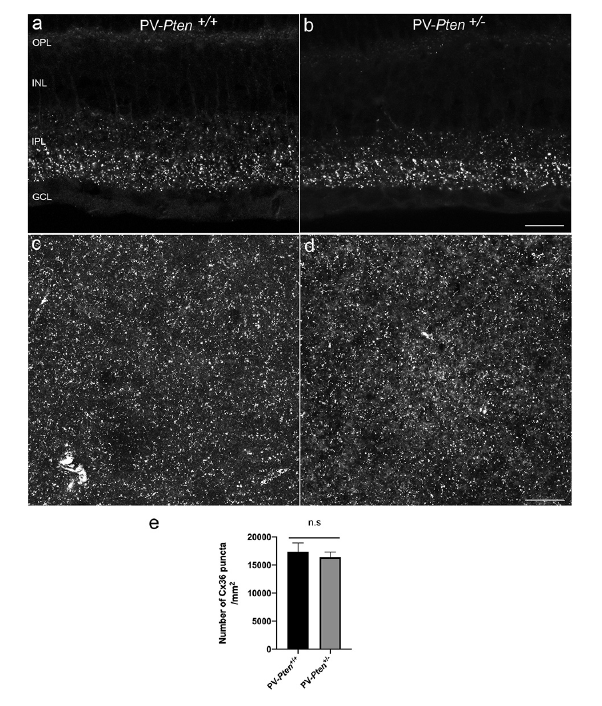
FIGURE 9 | Cx36 immunoreactivity in PV- Pten +/+ and PV- Pten + / − retinas. (A) Cx36 immunoreactivity in retinal sections in PV- Pten +/+ . (B) Cx36 immunoreactivity in retinal sections in PV- Pten +/- . (C) A maximum projection of Cx36 immunoreactivity in PV- Pten +/+ wholemount retinas at 1.0 mm from the optic nerve head. (D) A maximum projection of Cx36 immunoreactivity in PV- Pten + / − wholemount retinas at 1.0 mm from the optic nerve head. (E) Histogram indicating the mean ( ± SEM) of Cx36 puncta in PV- Pten +/+ and PV- Pten +/- whole mounted retinas ( n = 9 PV- Pten +/+ retinas; n = 3 PV- Pten + / − retinas, P > 0.05, Mann-Whitney test). z-step = 0.3 µ m. Four (A,B) and 16 (C,D) optical sections were compressed for viewing. n.s., not significant. Scale bar = 50 µ m. retinas. The average number of coupled RGCs to OFF α - RGCs was 0.5 ± 0.2 cells in the GCL and their average somal diameter was 16.8 ± 0.9 µ m ( n = 4 cells). The average number of coupled cells to displaced amacrine cells ( P < 0.0001; Mann-Whitney test, Figures 7E,G ) was 2.1 ± 0.5 cells in the GCL with an average somal diameter of 8.5 ± 0.3 µ m ( n = 12 cells). There was also a significant reduction in cell coupling to amacrine cells in the INL compared to PV- Pten +/+ retinas ( P < 0.05; Mann-Whitney test, Figures 7F,G ). The average number coupled amacrine cells in the INL was 1 ± 0.4 cells with an average somal diameter of 7.3 ± 0.4 µ m ( n = 12